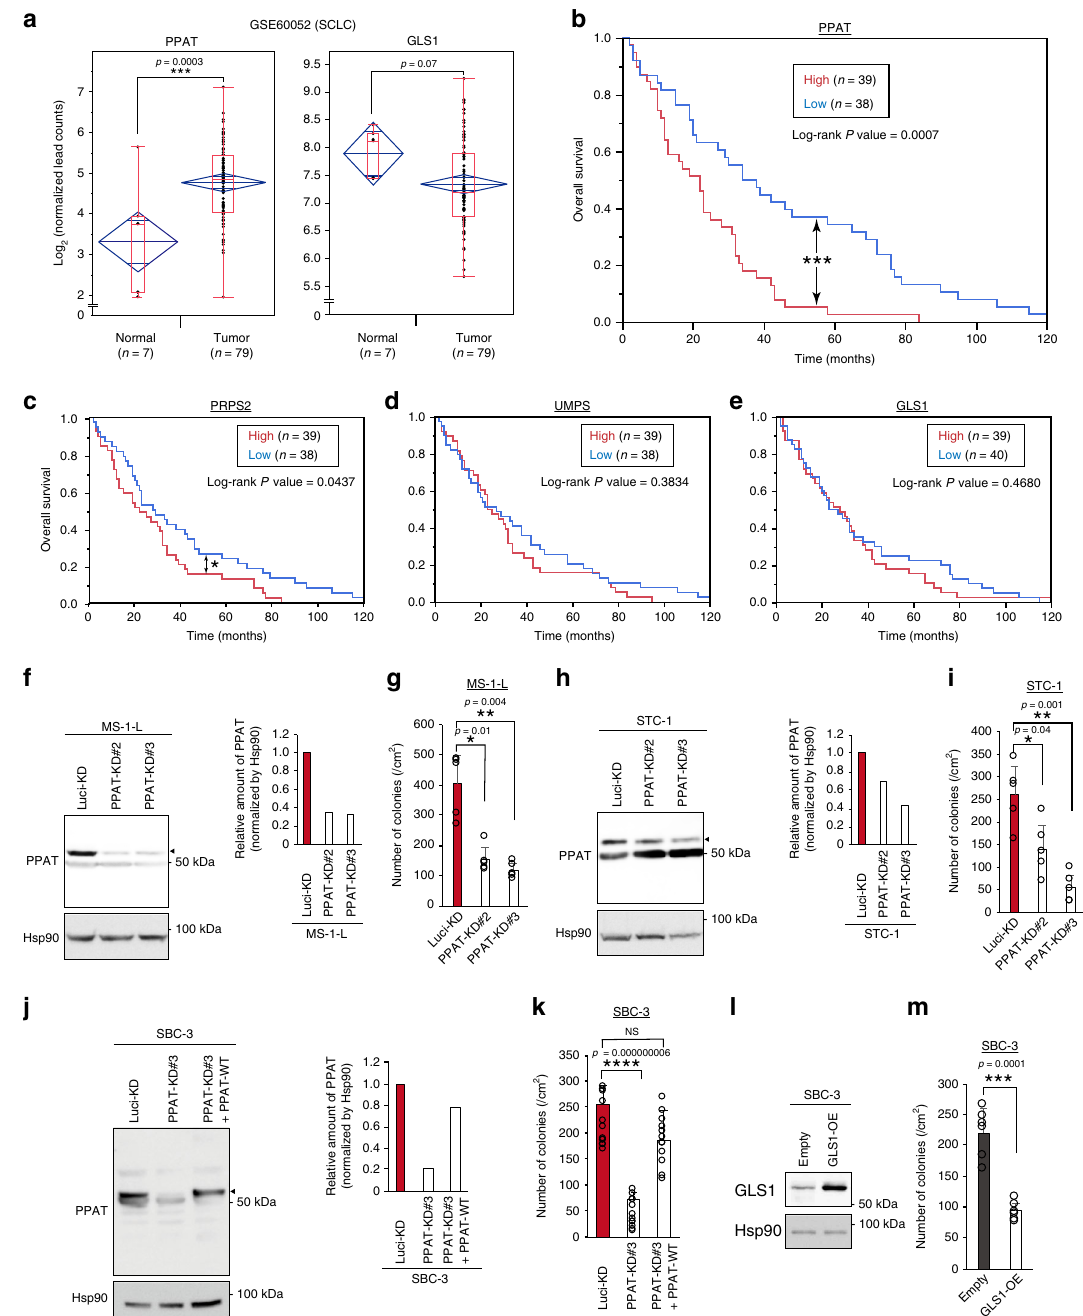
Fig. 7 PPAT as a new therapeutic target for SCLC. a Box plots of PPAT and GLS1 gene expression levels in normal lung tissue ( n = 7) or tumors ( n = 79) from SCLC patients (GSE60052 data set). The upper and lower limits of the red boxes represent quartiles, with the line within the boxes indicating the median and the whiskers showing the extremes. Blue diamonds indicate con fi dence intervals. b – e Kaplan-Meier survival analysis for SCLC patients with high or low expression levels of PPAT ( b ), PRPS2 ( c ), UMPS ( d ), or GLS1 ( e ) genes in their tumors (GSE60052). Patients were divided according to the median gene expression level (Two-sided, P ≤ 0.05). f – k Immunoblot analysis of PPAT in MS-1-L ( f ), STC-1 ( h ), and SBC-3 ( j ) SCLC cell lines stably infected with retroviruses encoding luciferase control (Luci-KD) or two independent PPAT (PPAT-KD#2 or -#3) shRNAs, was conducted with single time. The intensity of PPAT bands (indicated by the arrowheads) was measured by densitometry ( n = 1). In j , PPAT-depleted SBC-3 cells were also infected with a retrovirus for wild-type (WT) human PPAT. The proliferation rate in 3-D culture for the infected MS-1-L, STC-1, and SBC-3 cell lines was also determined ( n = 5 [ g and i ] or 12 [ k ]). l Immunoblot analysis of GLS1 in SBC-3 cells stably overexpressing (OE) wild-type human GLS1 or infected with the corresponding empty retrovirus, was conducted with single time. m Proliferation rate in 3-D culture ( n = 6) for cells as in l . In g , i , m , colonies were counted in two randomly selected fi elds in each of three dishes ( n = 6). In k , colonies were counted in four randomly selected fi elds in each of three dishes ( n = 12). Quantitative data in g , i , k , and m are means + s.d. * P < 0.05, ** P < 0.01, *** P < 0.001, **** P < 0.0001 (paired two-tailed Student ’ s t -test [ a , g , i , k , m ] or log- rank test [ b – e ]). Source data are provided as a Source Data fi